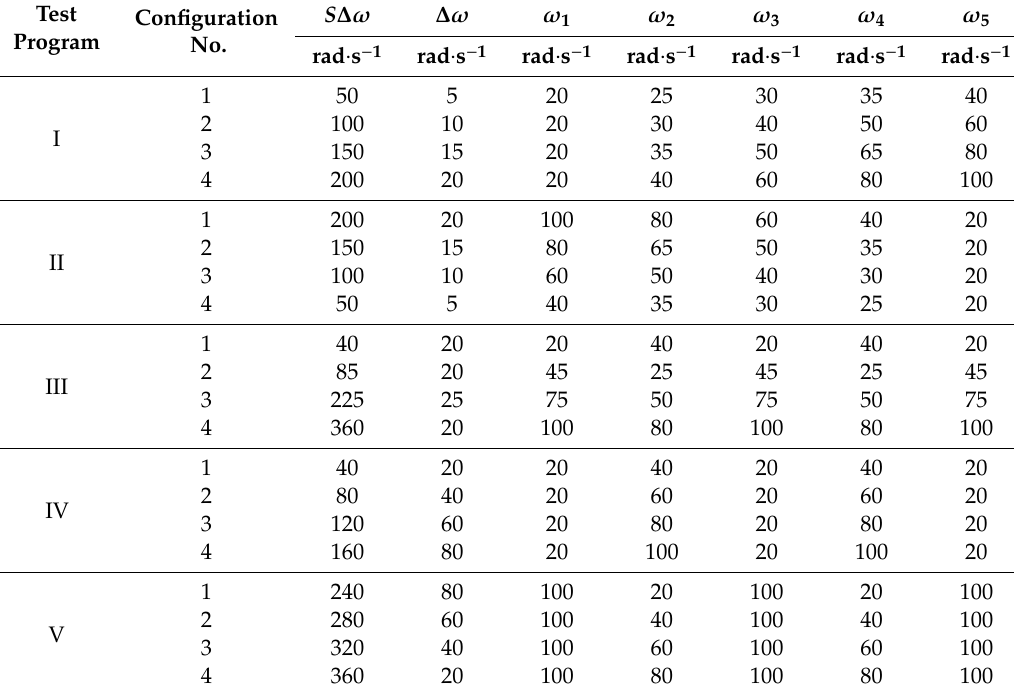
Table 2. Settings of the five-disc mill control